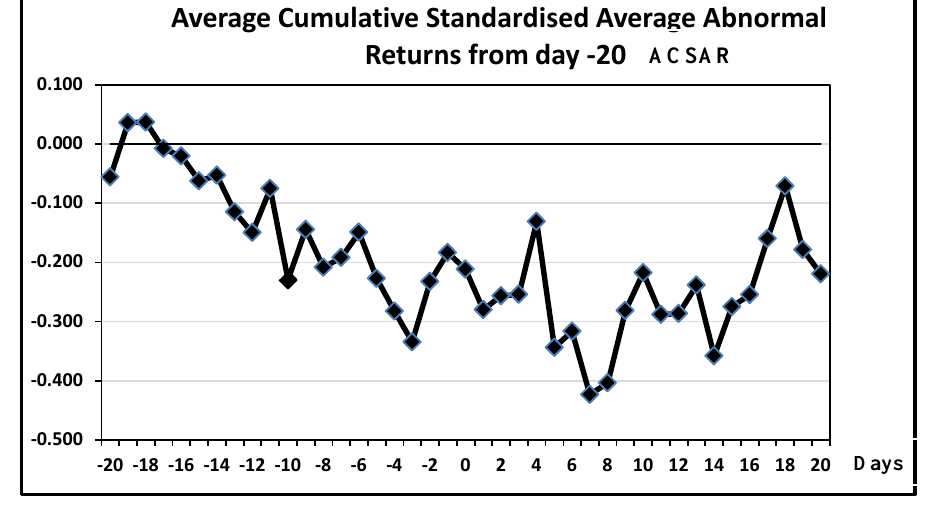
FIGURE 2: ASCAR from day -20 Source: Authors’